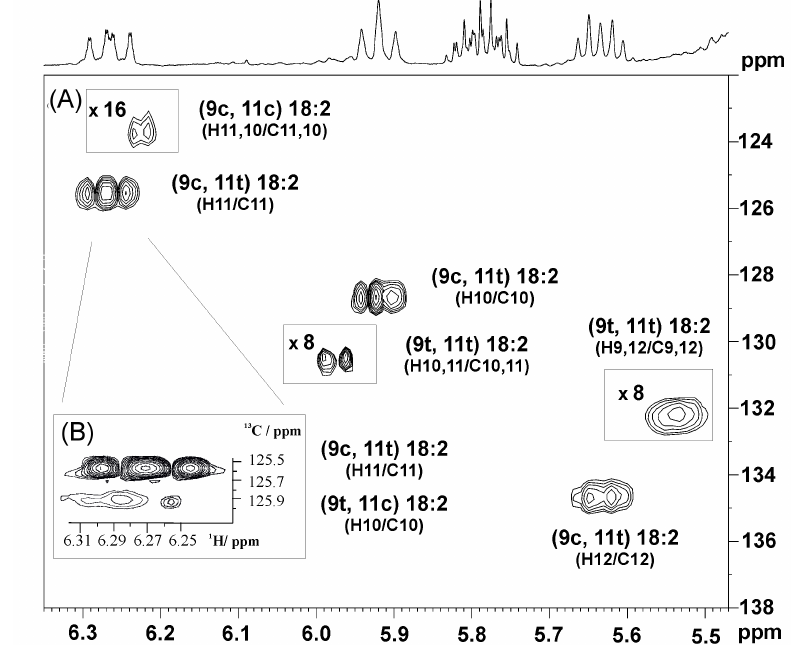
Figure 27. Selected regions of 500 MHz 1 H- 13 C HSQC spectra of the lipid fraction of a lyophilized milk sample of Figure 26. ( A ) With 13 C shielding spectral range from 0 to 160 ppm and ( B ) with reduced 13 C spectral range from 112 to 142 ppm. Experimental conditions: 298 K, 40 repetitions of 256 increments, total experimental time 4 h 55 min and 5 h 49 min for ( A , B ), respectively. Adopted, with permission, from [56]. Copyright 2014, Elsevier B.V.